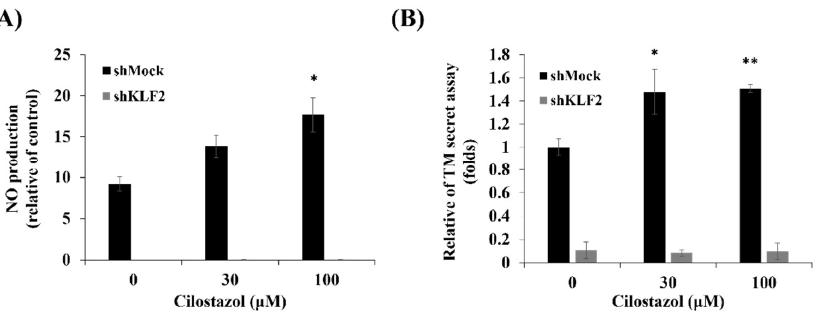
Figure 5. The NO production and TM secretion on cilostazol-treated shKLF2 cells. The HUVECs,